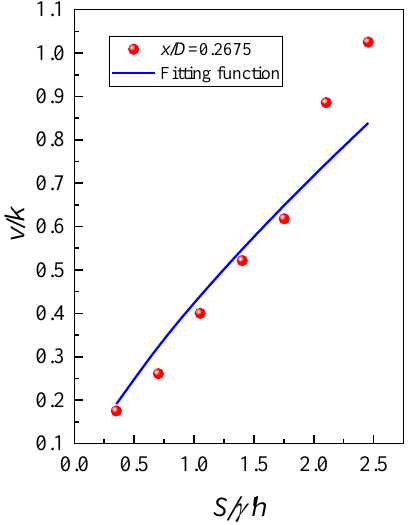
Figure 7. The hydraulic gradient with x/D = 0.2675 and h/D = 1.25.